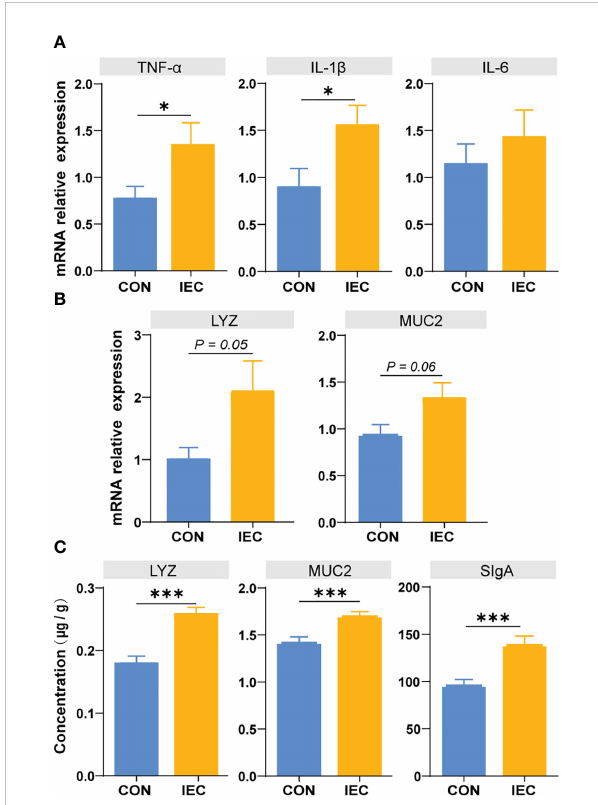
FIGURE 4 Determination of immune function factors in ileum of rats at 48 hpi. (A, B) The contents of TNF- a , IL-6, IL-1 b , LYZ and MUC2 in ileum issue were measured by qPCR to evaluate the degree of immune response (n =10/group). (C) The contents of LYZ, MUC2 and SIgA in ileum musoca were measured by ELISA to evaluate the degree of immune response (n =10/group). The data are presented as mean ± SEM. Asterisks indicate signi fi cant difference between the IEC group and the CON group (* P < 0.05; *** P < 0.001). TNF-a , Tumor necrosis factor-a; IL , Interleukin; LYZ , Lysozyme; MUC , Mucin; SIgA , secretory immunoglobulin A; hpi, hours post